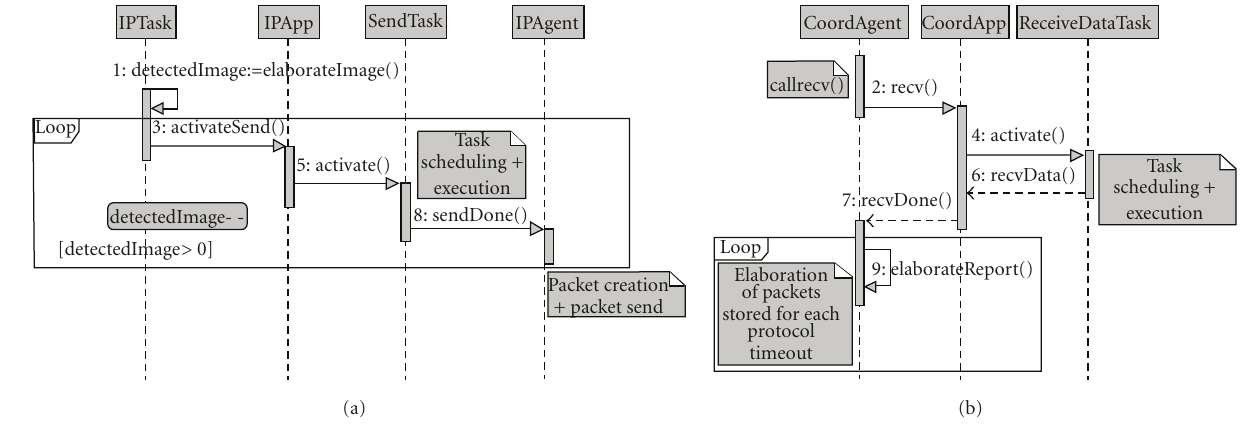
Figure 22: The UML sequence diagrams for sending (a) and receiving (b)